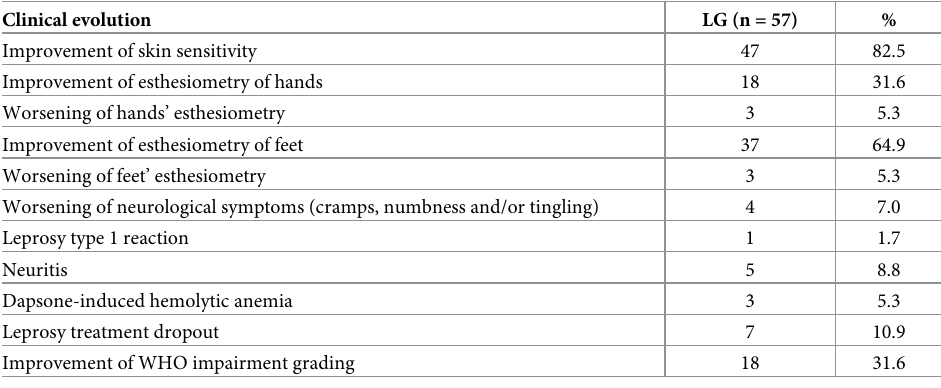
Table 6. Clinical data and follow up in the leprosy patients treated. Clinical